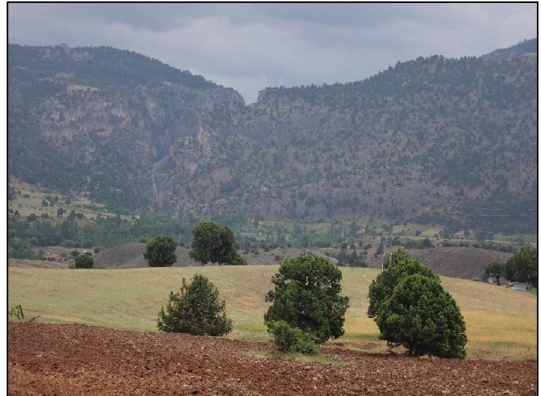
Fig. 7 Kamıslı and surroundings are characterized by a strait valley process